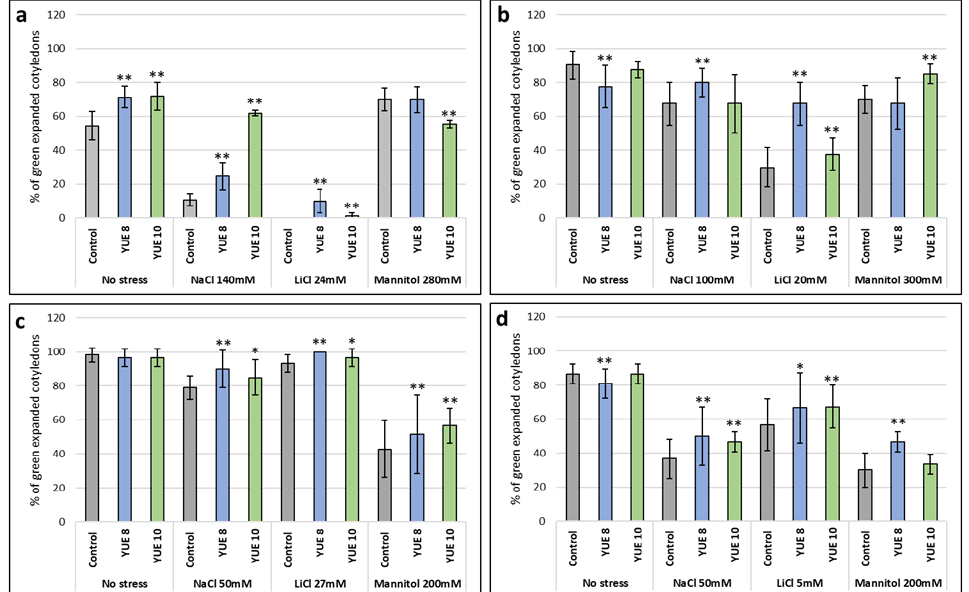
Figure 3. Effect of yucca extract on ( a ) A. thaliana Col 0 WT ( b ) broccoli, ( c ) tomato and ( d ) lettuce seed germination under control conditions (no stress) and saline (NaCl and LiCl) and osmotic (mannitol) stress. The optimal concentration of yucca extracts used in the different plant species tested was 0.8 mg/mL ( w / v ). The X axis indicates the different concentrations of abiotic stressors. Control without extract (gray); YUE 8 (blue) and YUE 10 (green), while the Y axis represents the percentage of expanded green cotyledons. The bars represent a standard error. * p < 0.05 by Student’s tests for increased germination compared to the control; ** p < 0.01 by Student’s tests for increased germination compared to the control.